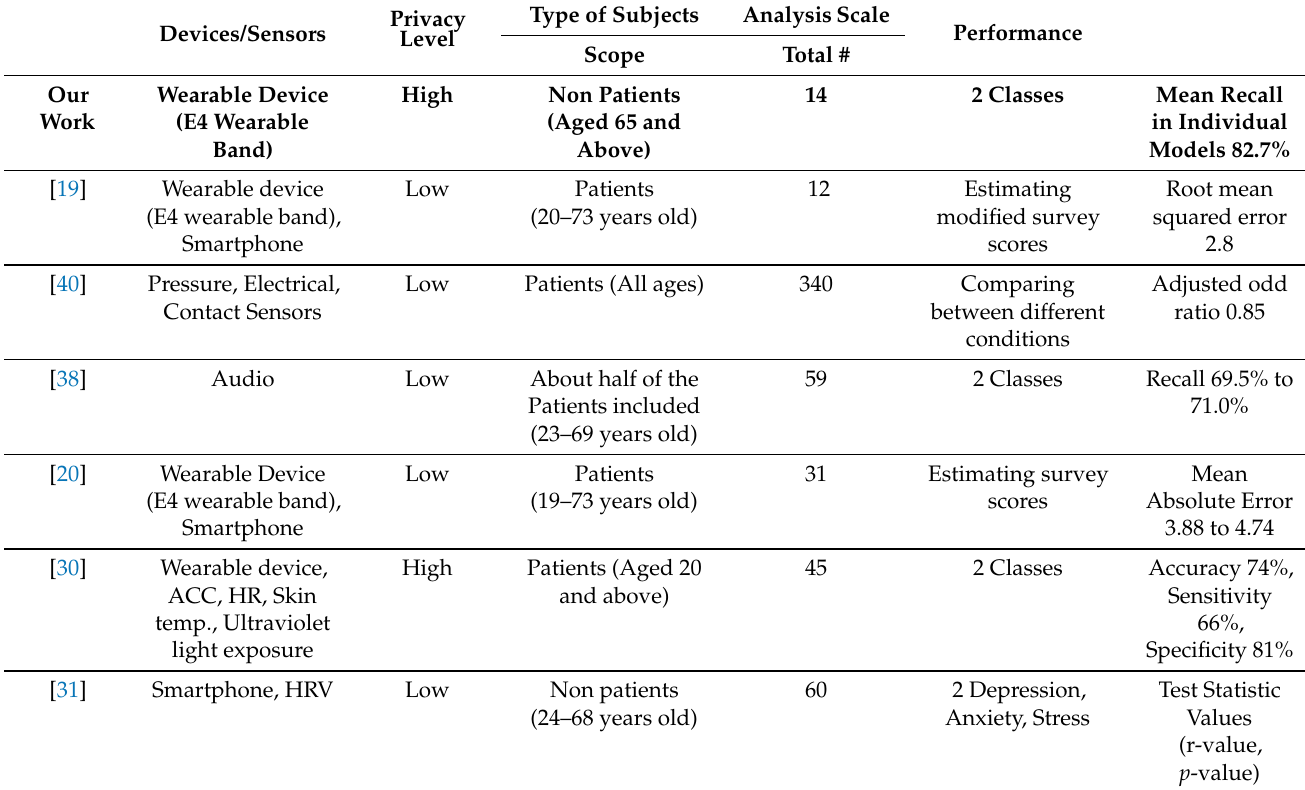
Table 1. Summary of Related